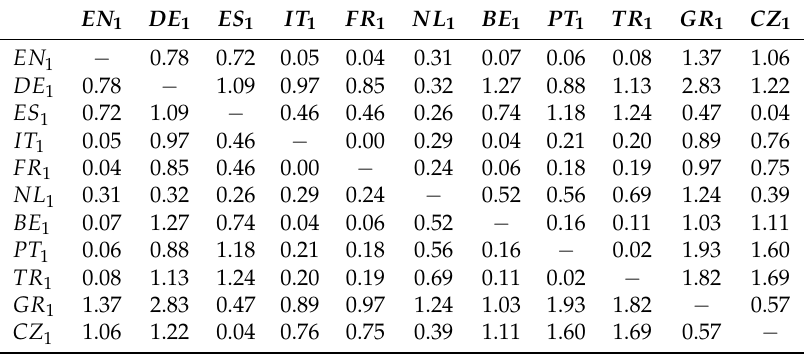
Table 6. Jeffrey divergence (multiplied by 100) for the highest leagues over all ten seasons. EN 1 DE 1 ES